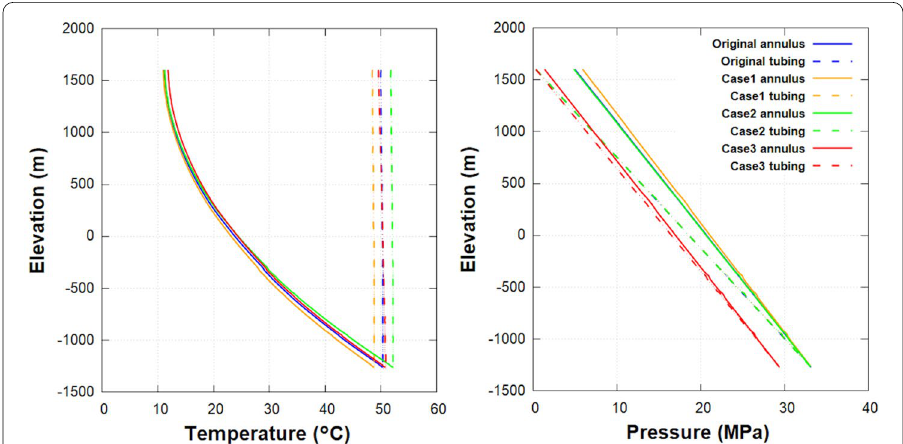
Fig. 9 Radii analysis for fixed ˙ m = 5 ( kg / s ) over 30 years. Left—temperature vs. elevation for the original, annulus reduction (Case1), annulus increase (Case2), and tubing increase (Case3). Right—pressure vs. elevation for the same cases. Solid lines represent annulus and dashed lines represent tubing data, respectively. Legend applies to both graphs. The original case (in blue) represents the base-case scenario